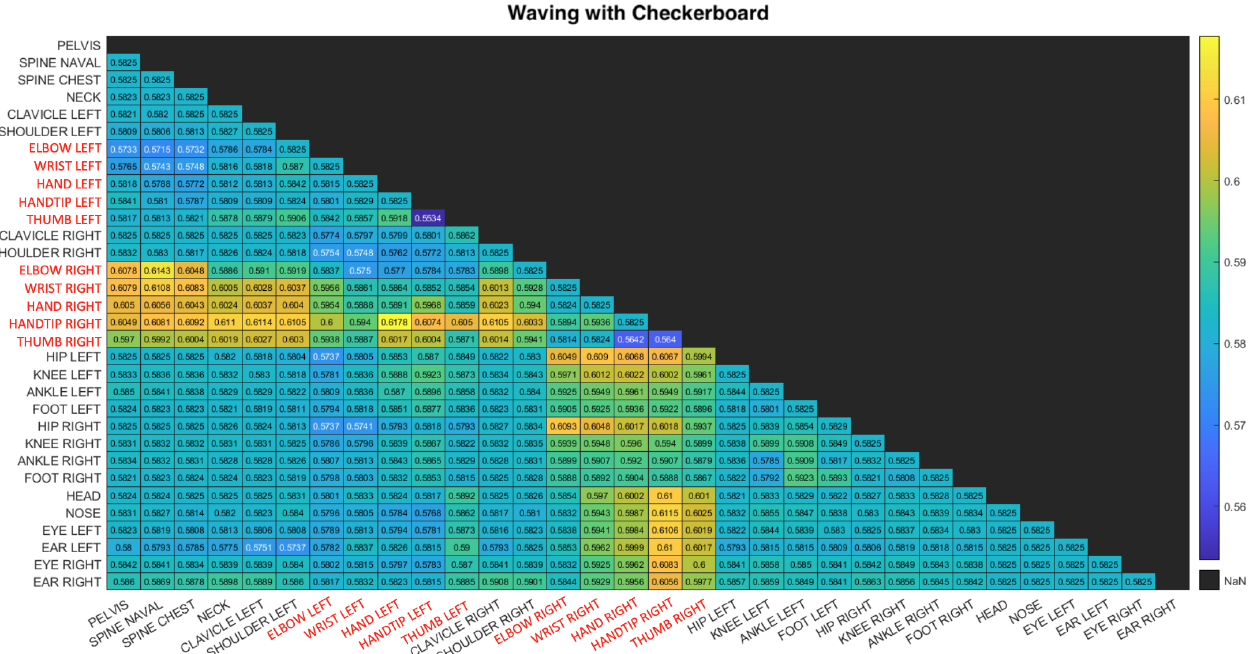
Figure 11. Matrix of Coefficient of Variation values (CV) for a session in which a checkerboard is waved. It can be seen that the highest CV values are associated with hand joints (colored in red) and face joints that are not